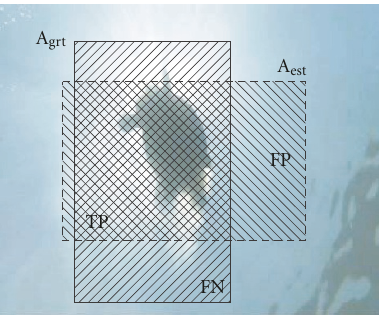
Figure 10: Comparison of the hand-labelled ground truth A grt and automatically estimated salient image regions A est